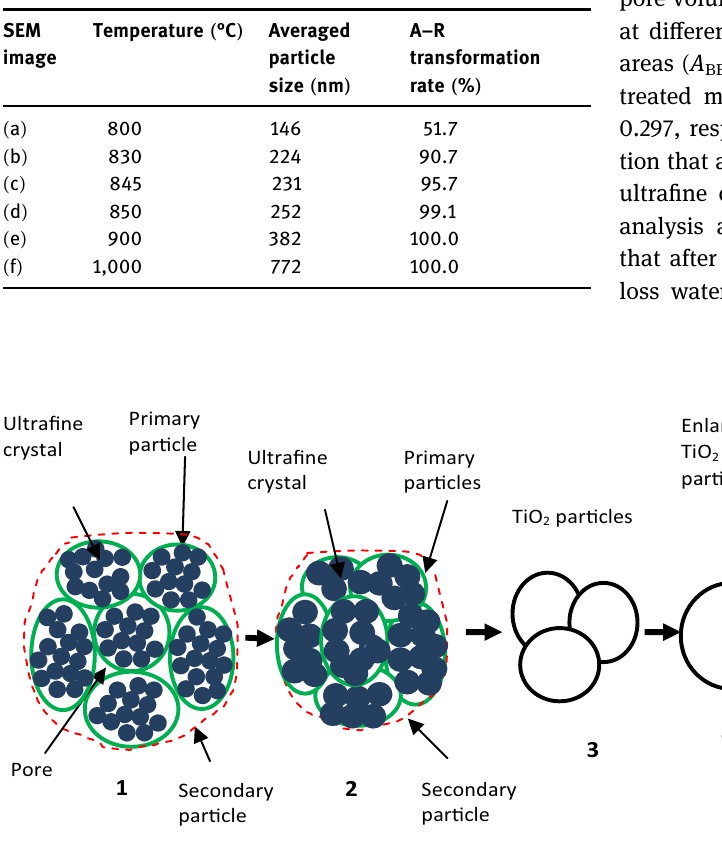
Figure 6: The mechanism of the transformation from metatitanic acid to crystalline titanium dioxide during